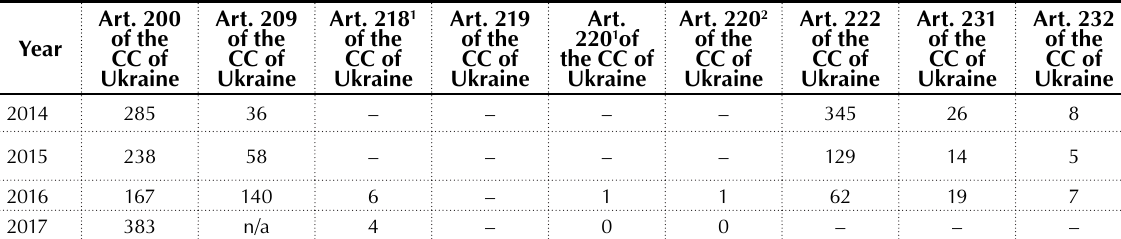
Table 3. Dynamics of crime in